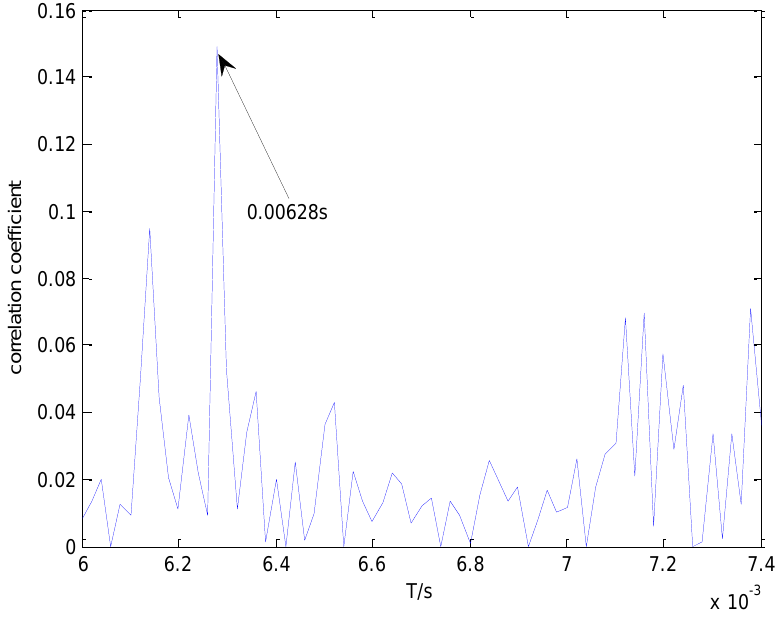
Figure 17. Maximal correlation coefficients for different elements from set T, using the conventional method and a loading of 1 t.